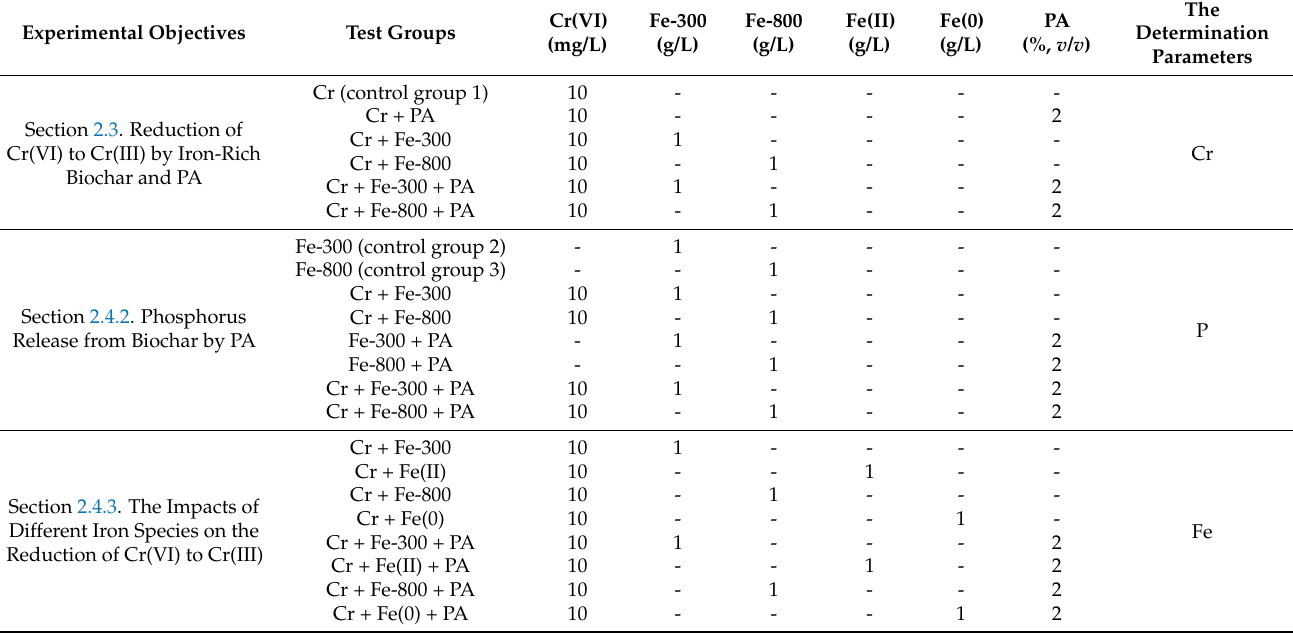
Table 1. The experimental design for the potential synergistic effects of iron-rich biochar and